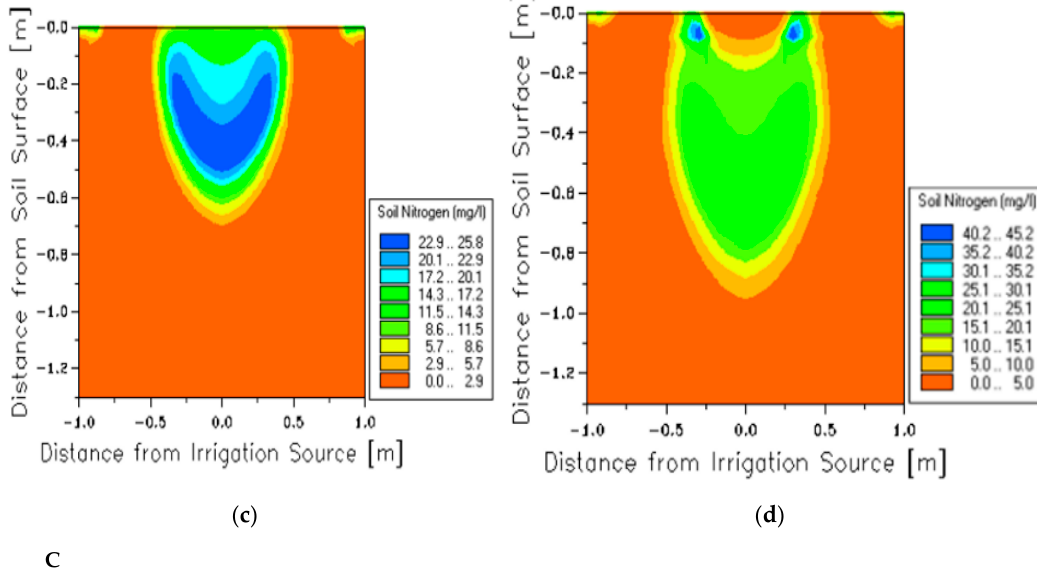
Figure 5. A ( a – d ). The distribution of soil moisture through stages ( a – d ) of growth in the soil profile